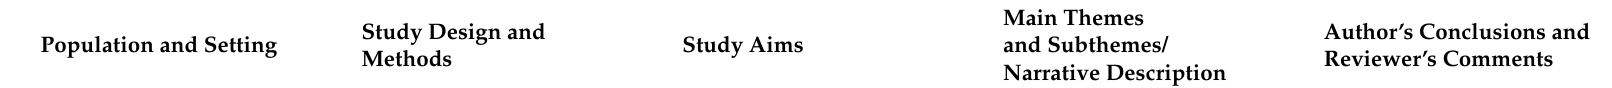
Table A3. Characteristics and summary of qualitative studies